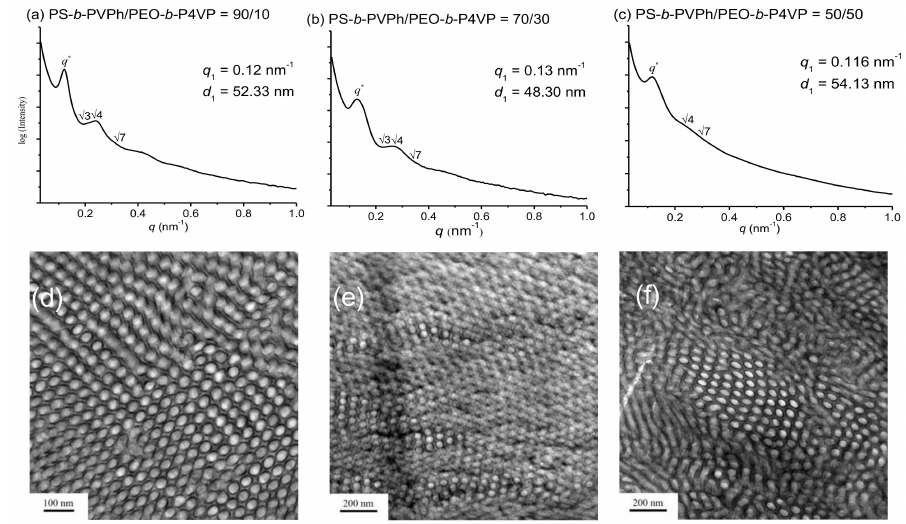
Figure 11. SAXS analyses and TEM images staining with I2 and RuO 4 of PS- b -PVPh/PEO- b -P4VP mixture mixture at room temperature of ( a , d ) 90/10, ( b , e ) 70/30, and ( c , f )